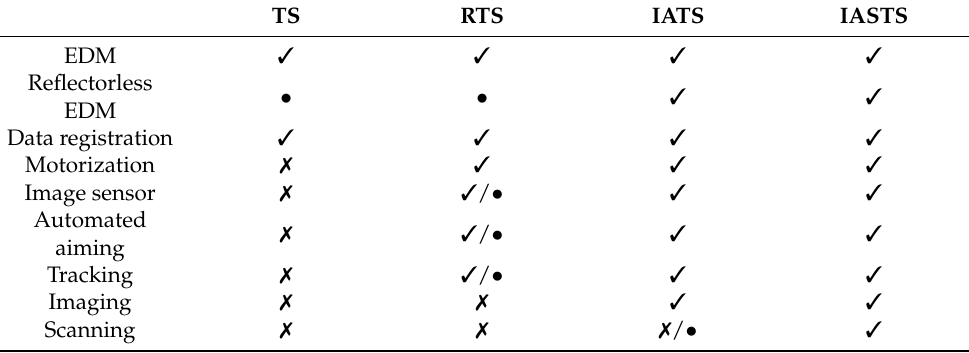
Table 3. Different types of TS according to integrated sensors and